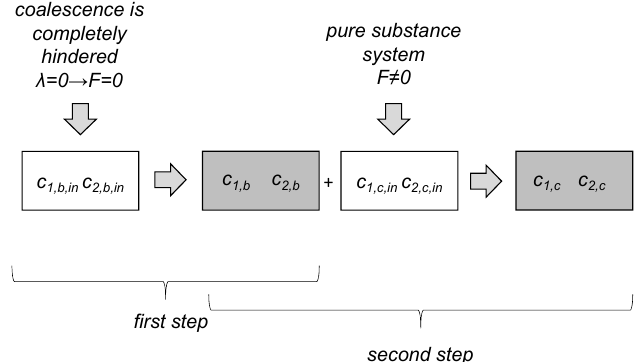
Figure 4. Schematic visualization of the two-step parameter estimation procedure. Initial parameters ( c 1, b , in , c 2, b , in for breakage, c 1, c , in and c 2, c , in for coalescence) were taken from another substance